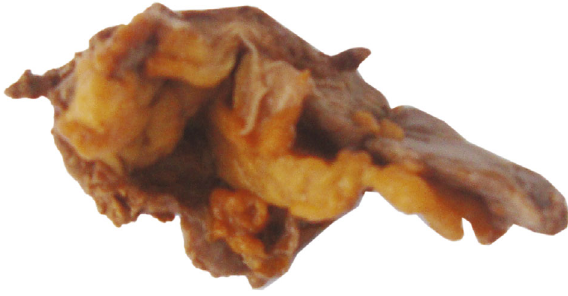
Figure 2: The right adrenal mass after